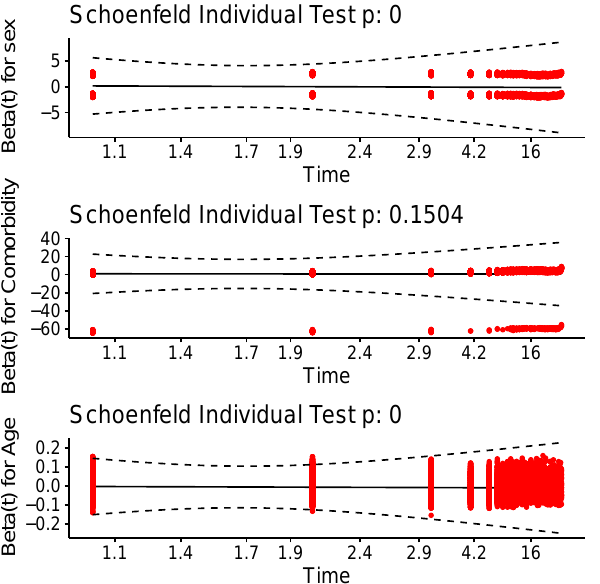
Figure 1. The conventional Schoenfeld residuals from the application of the coronavirus disease 2019 (COVID-19) data set while taking the test p -value for the sex and comorbidity covariates into